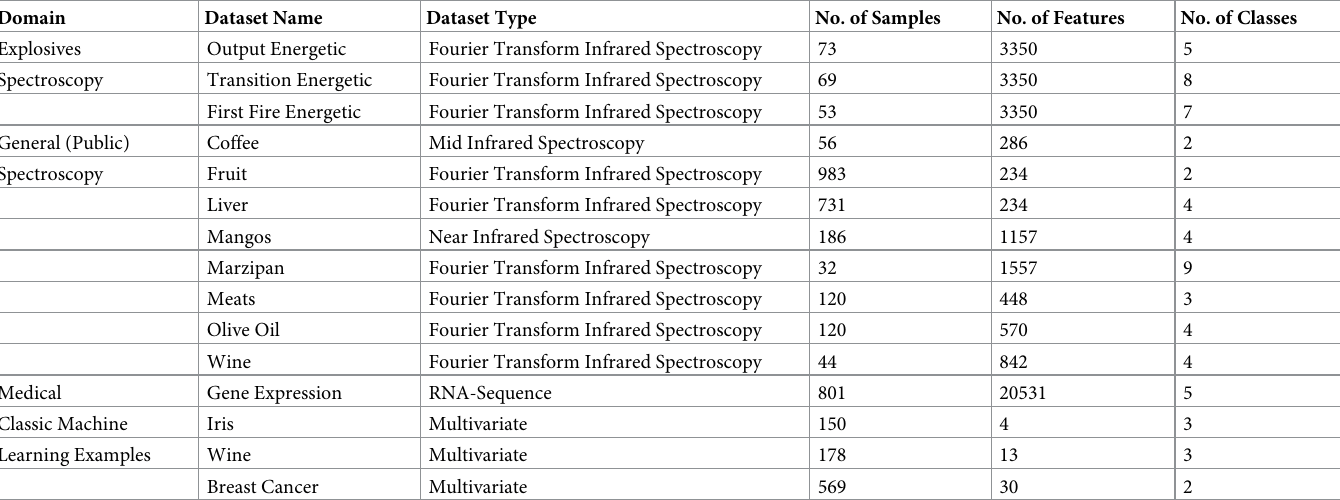
Table 1. Characteristics of the validation datasets.